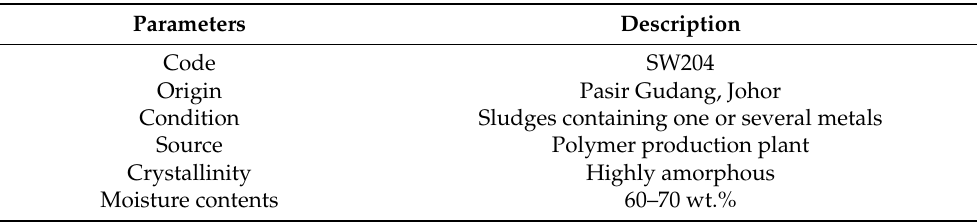
Table 1. Sample description of solid waste sludge. Parameters Description